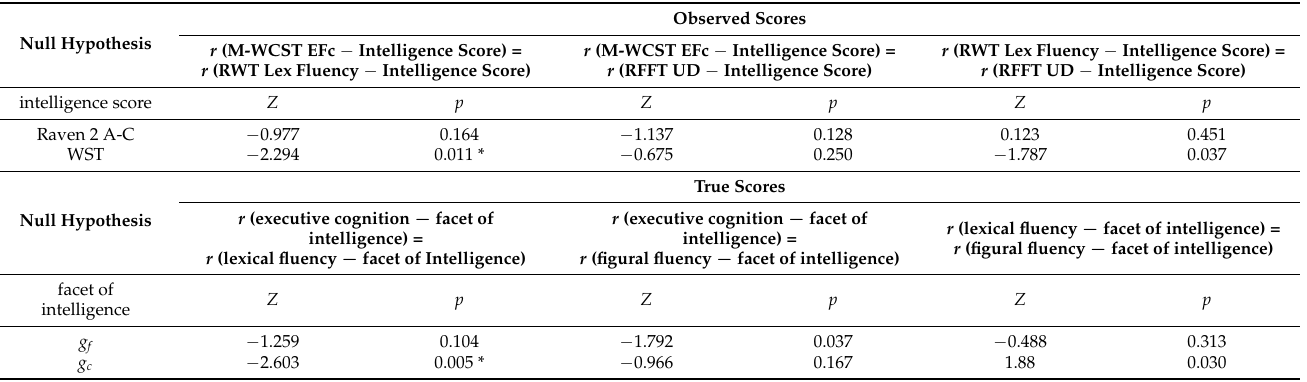
Table 8. Are correlations between executive functioning (EF x ) and g . (i.e., either g f or g c ) equal to correlations between EF y and g ? Observed